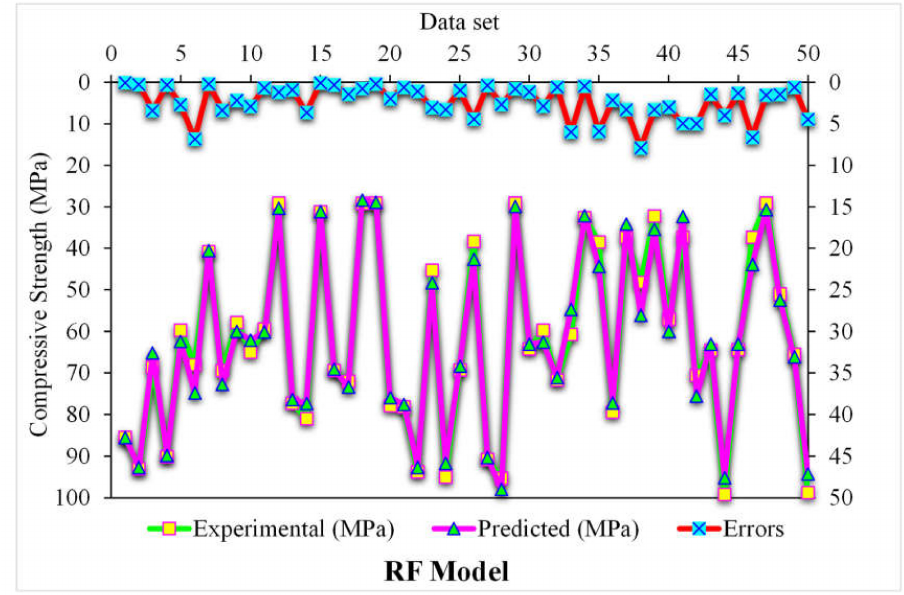
Figure 12. Distribution of experimental and BSA predicted values with errors.